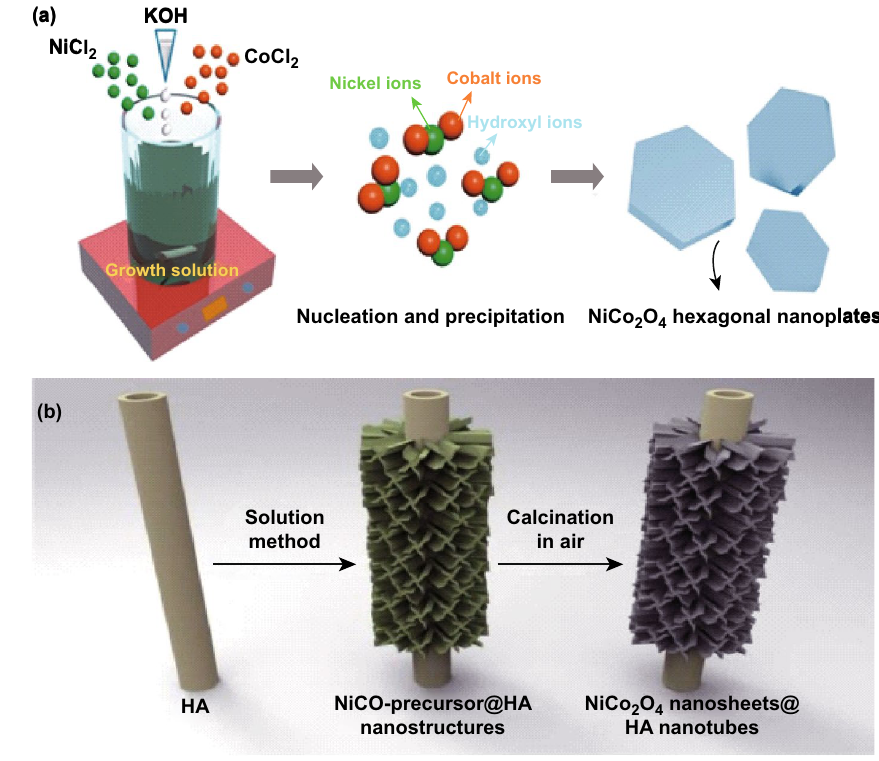
Fig. 13 a Schematic representation for the synthesis of hexagonal NiCo 2 O 4 nanosheets, Reproduced with permission from Ref. [151]. Copy- right © 2019 Elsevier Ltd. and b hierarchical NiCo 2 O 4 nanosheets@halloysite nanotubes via co-precipitation method. Reproduced with